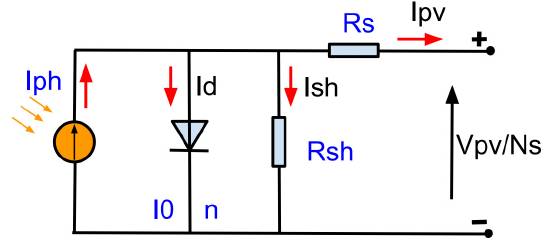
Figure 9 . Single-diode model PV cell equivalent circuit .